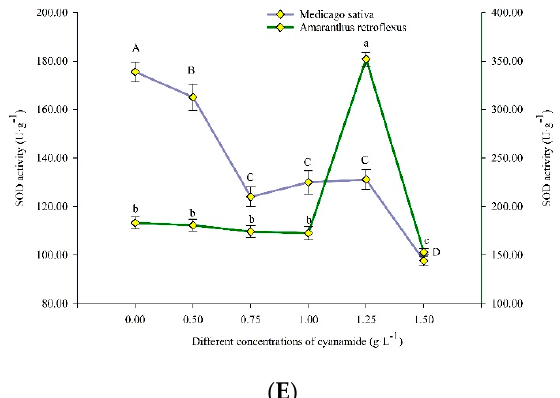
Figure 5. Ascorbate peroxidase (APX), catalase (CAT), peroxidase (POD), superoxide dismutase (SOD) activities, and malondialdehyde (MDA) content in alfalfa and amaranth exposed to CA. ( A ) The ascorbate peroxidase (APX) activity in alfalfa and amaranth exposed to CA. ( B ) The catalase (CAT) activity in alfalfa and amaranth exposed to CA. ( C ) The peroxidase (POD) activity in alfalfa and amaranth exposed to CA. ( D ) The superoxide dismutase (SOD) activity in alfalfa and amaranth exposed to CA. ( E ) The malondialdehyde (MDA) content in alfalfa and amaranth exposed to CA. Different letters in columns indicate significant differences among treatments at p < 0.05 (LSD test).